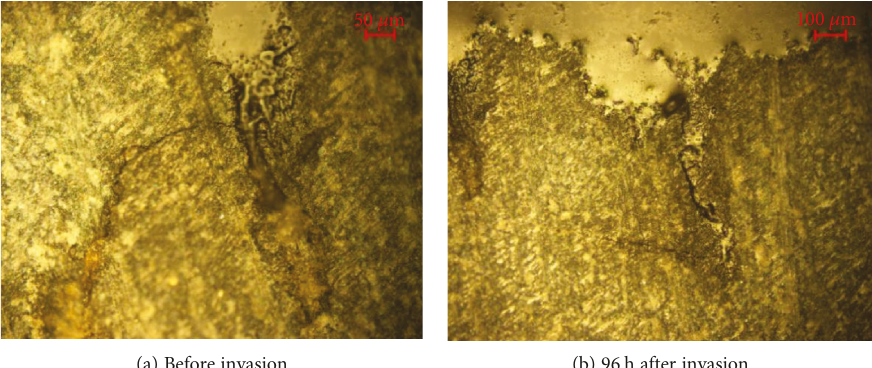
Figure 3: Morphological changes of microcracks under the intrusion of drilling fl